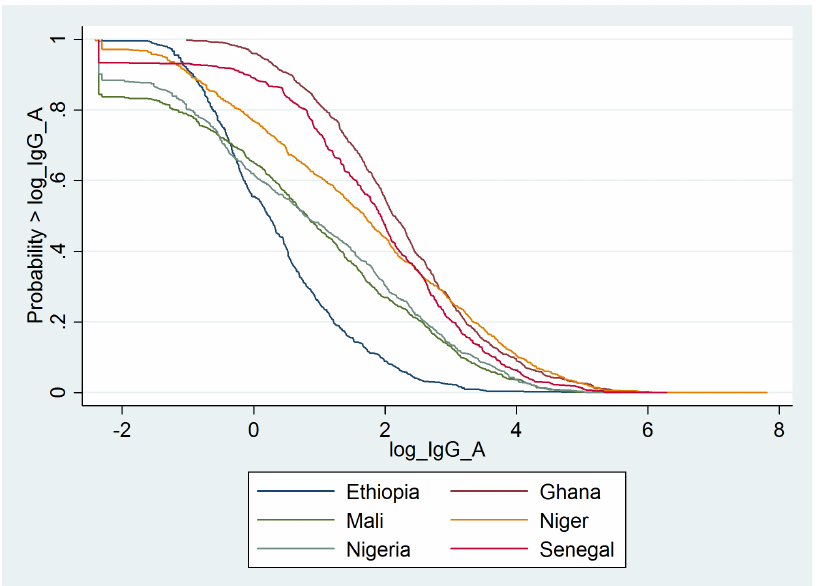
doi:10.1371/journal.pone.0147928.g001